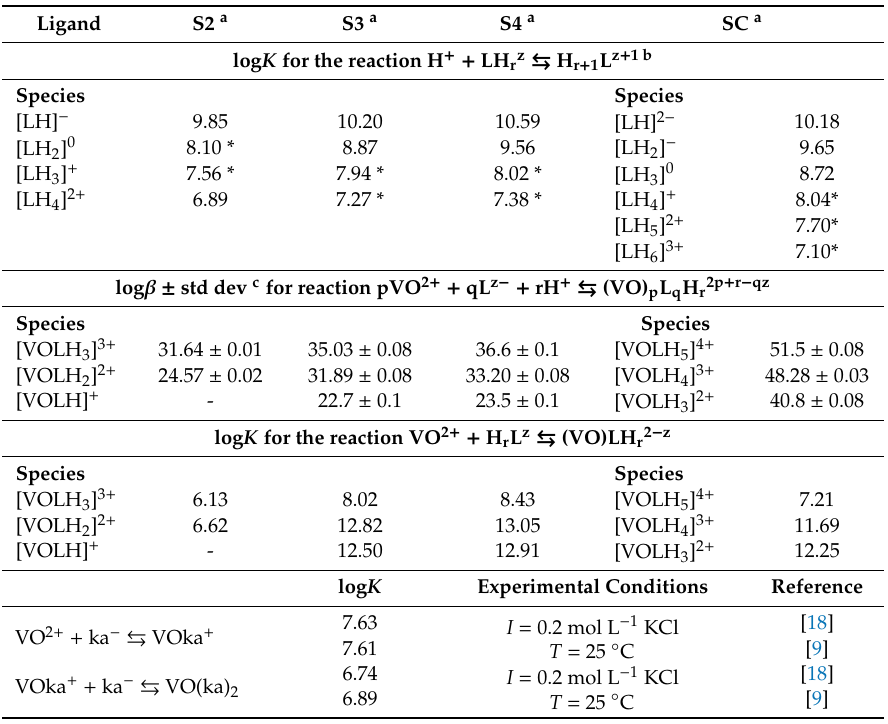
Table 1. Formation constants. Protonation constants [12,13] of the ligands and formation constants for the species of oxovanadium(IV). The formation constants are obtained from the analysis of pH-metric data (ionic strength: 0.1 mol L − 1 in KCl; temperature: 25 ◦